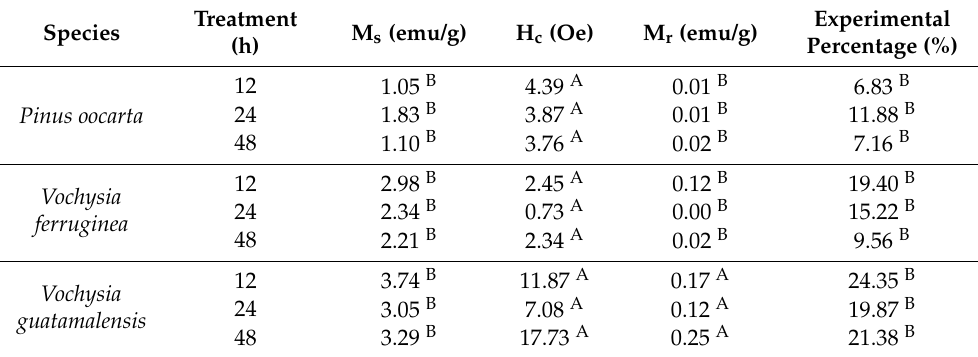
Table 3. The coercivity (H c ), retentivity (M r ), saturation magnetization (M s ) and the experimental percentage of magnetic wood with three different immersion times in ammonia in three tropical wood species from fast-growth plantations in Costa Rica. Treatment Species